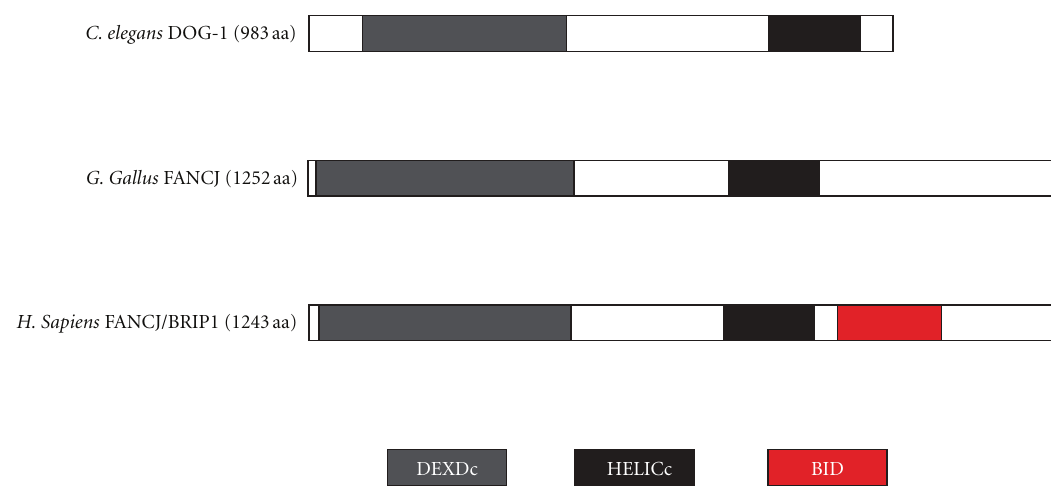
Figure 2: Protein schematic of FANCJ orthologs. C. elegans DOG-1, 983 aa, chicken FANCJ, 1252 aa and human, 1243 aa FANCJ proteins illustrating the position of the conserved DEAD Box (DEXDc) and helicase (HELICc) domains. The BRCA-1 interaction domain of human FANCJ is illustrated (BID). A full protein sequence alignment of DOG-1 and human FANCJ is shown in